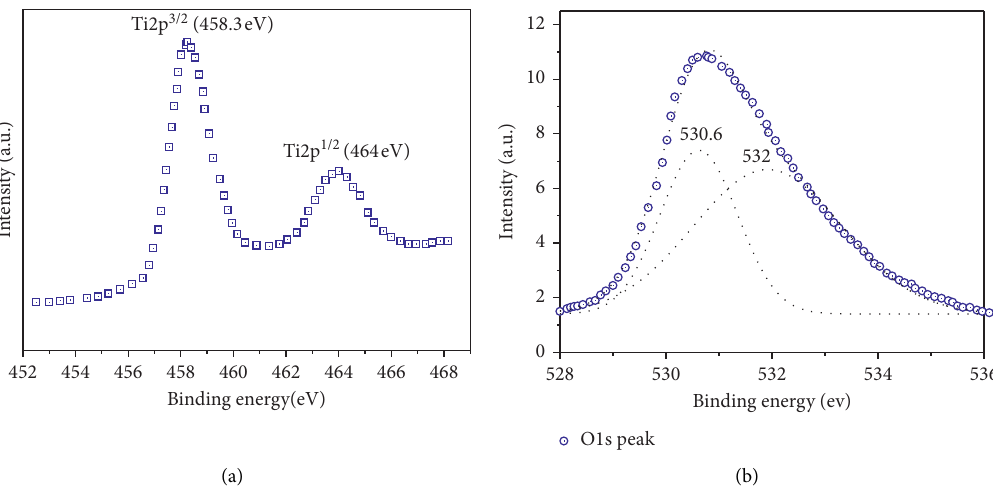
Figure 5: Ti2p XPS spectra for titanium anodized at 35V for 2min in 5M phosphoric acid. (a) Ti2p spectra; (b) O1s